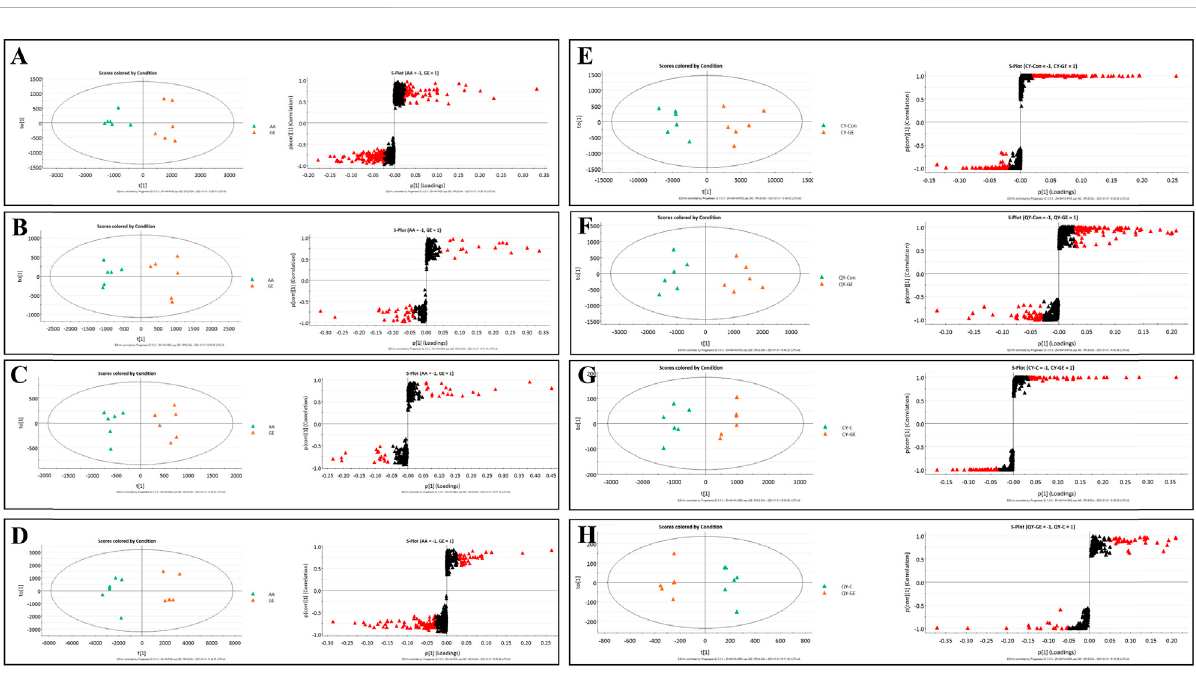
FIGURE 6 OPLS-DA score plots and S-plots of synovial, serum and MH7A cells samples after GE intervention. (A) OPLS-DA model in ESI + mode corresponding to synovial sample (GE vs. AA: R 2 Y = 0.92, Q 2 = 0.85); (B) OPLS-DA model in ESI − mode corresponding to synovial sample (GE vs. AA: R 2 Y = 0.84, Q 2 = 0.79); (C) OPLS-DA model in ESI + mode corresponding to serum samples (GE vs. AA: R 2 Y = 0.95, Q 2 = 0.81); (D) OPLS-DA model in ESI − mode corresponding to serum samples (GE vs. AA: R 2 Y = 0.93, Q 2 = 0.86); (E) and (F) Corresponding to OPLS-DA model in ESI + mode of MH7A cellssample(CY-GEvs.CY-C:R 2 Y=0.85,Q 2 =0.77;QY-GEvs.QY-C:R 2 Y=0.80,Q 2 =0.82); (G) and (H) CorrespondingtoOPLS-DAmodelin ESI − mode of MH7A cells sample (CY-GE vs. CY-C: R 2 Y = 0.75, Q 2 = 0.82; QY-GE vs. QY-C: R 2 Y = 0.88, Q 2 = 0.91); the variable with VIP > 1.0 was highlighted with a red frame in the S-plots of each